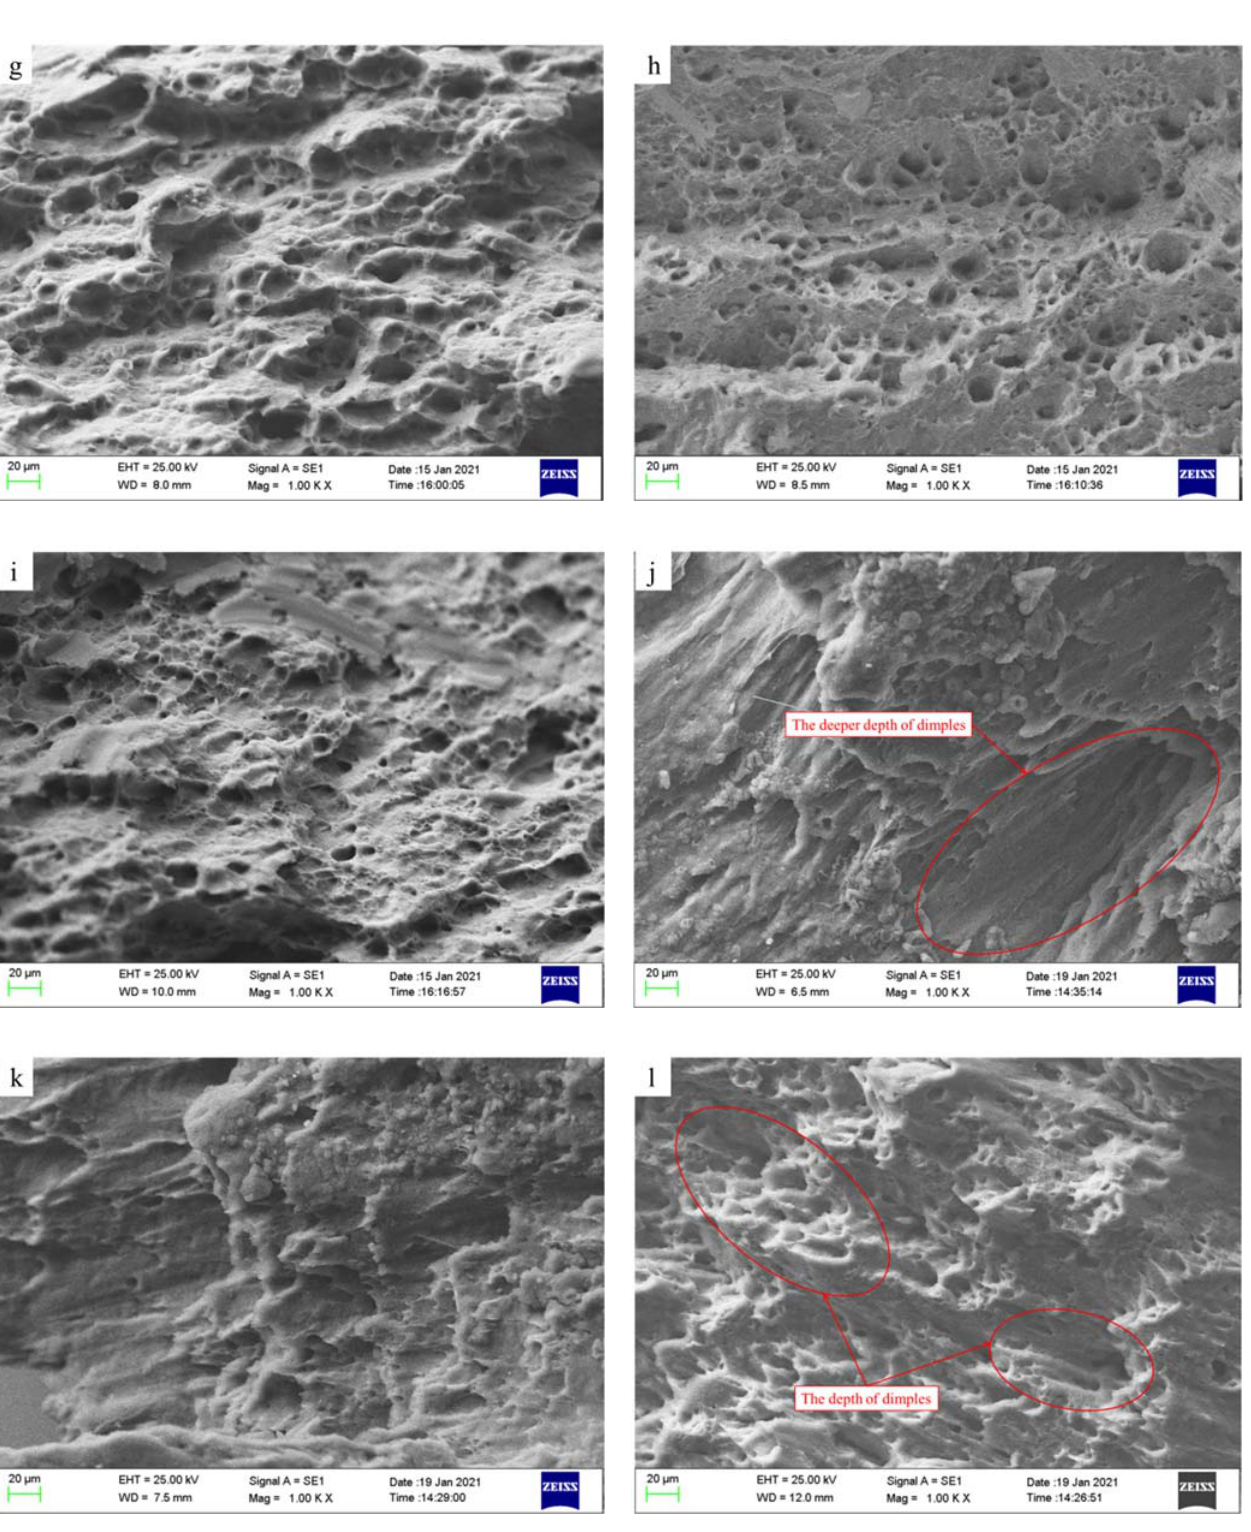
Figure 10. The fracture morphology of AZ31B at different temperatures and strain rates. ( a ) 0.017 s − 1 at 25 °C; ( b ) 0.17 s − 1 at 25 °C; ( c ) 0.34 s − 1 at 25 °C; ( d ) 0.017 s − 1 at 150 °C; ( e ) 0.17 s − 1 at 150 °C; ( f ) 0.34 s − 1 at 150 °C; ( g ) 0.017 s − 1 at 200 °C; ( h ) 0.17 s − 1 at 200 °C; ( i ) 0.34 s − 1 at 200 °C; ( j ) 0.017 s − 1 at 250 °C; ( k ) 0.17 s − 1 at 250 °C; ( l ) 0.34 s − 1 at 250 °C.